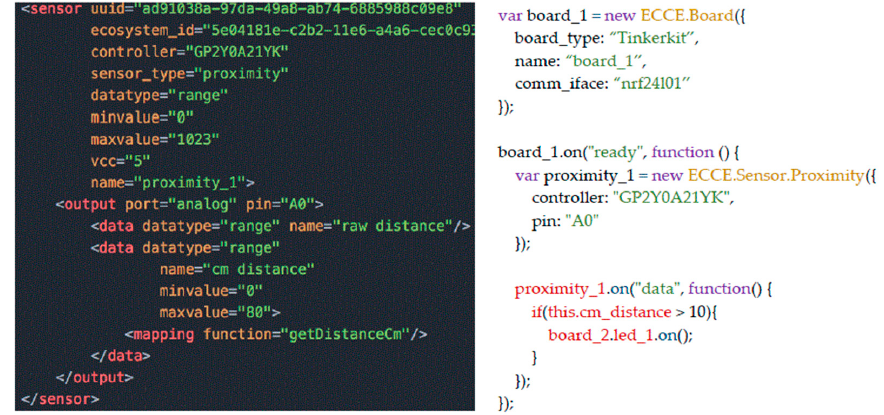
Figure 8. An example of the JavaScript code on the server (on the right ) that is generated by parsing the XML definition of a proximity sensor (on the left ).